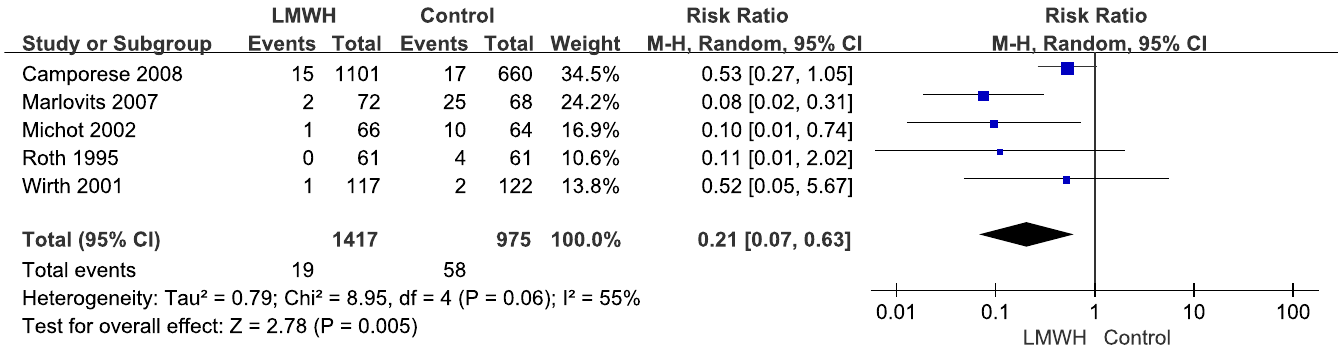
Fig 3. LMWH versus control. Asymptomatic deep vein thrombosis during